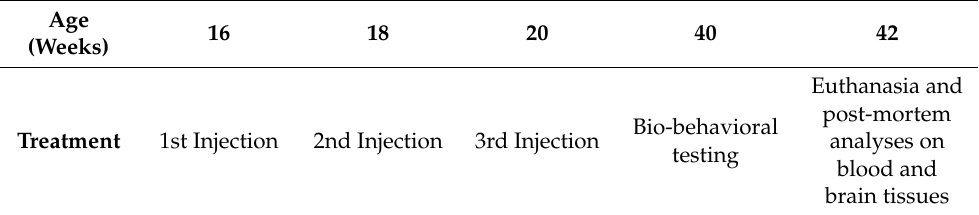
Table 1. Treatments and analyses of APP/PS1 mice as function of their